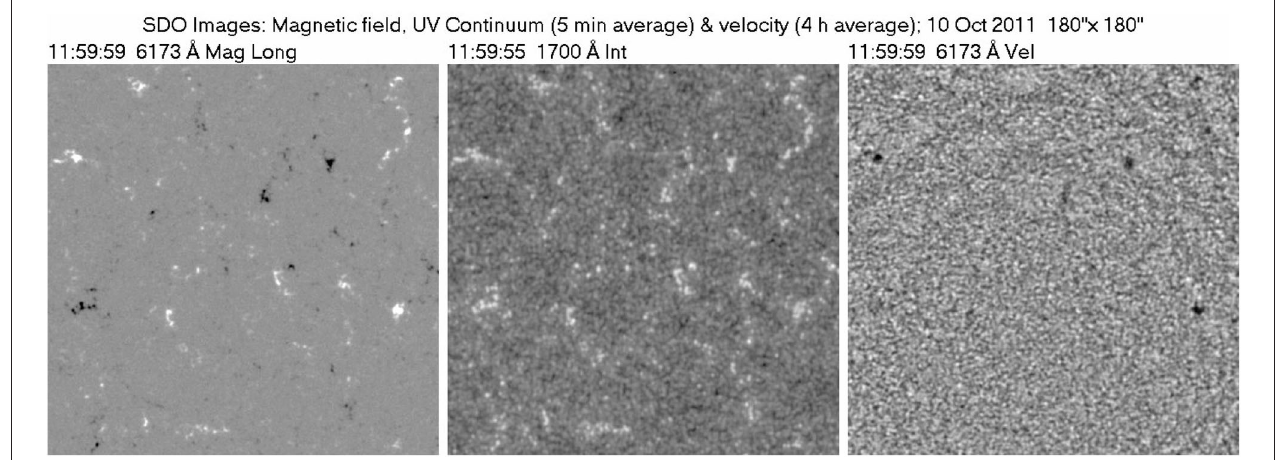
FIGURE 6 | Line of sight magnetic field from HMI/SDO (Left) , intensity in the 1700Å band from AIA/SDO (Middle) and line of sight velocity averaged over 4 h from HMI/SDO (Right) ; downflows are dark, upflows bright. Images produced by the author.